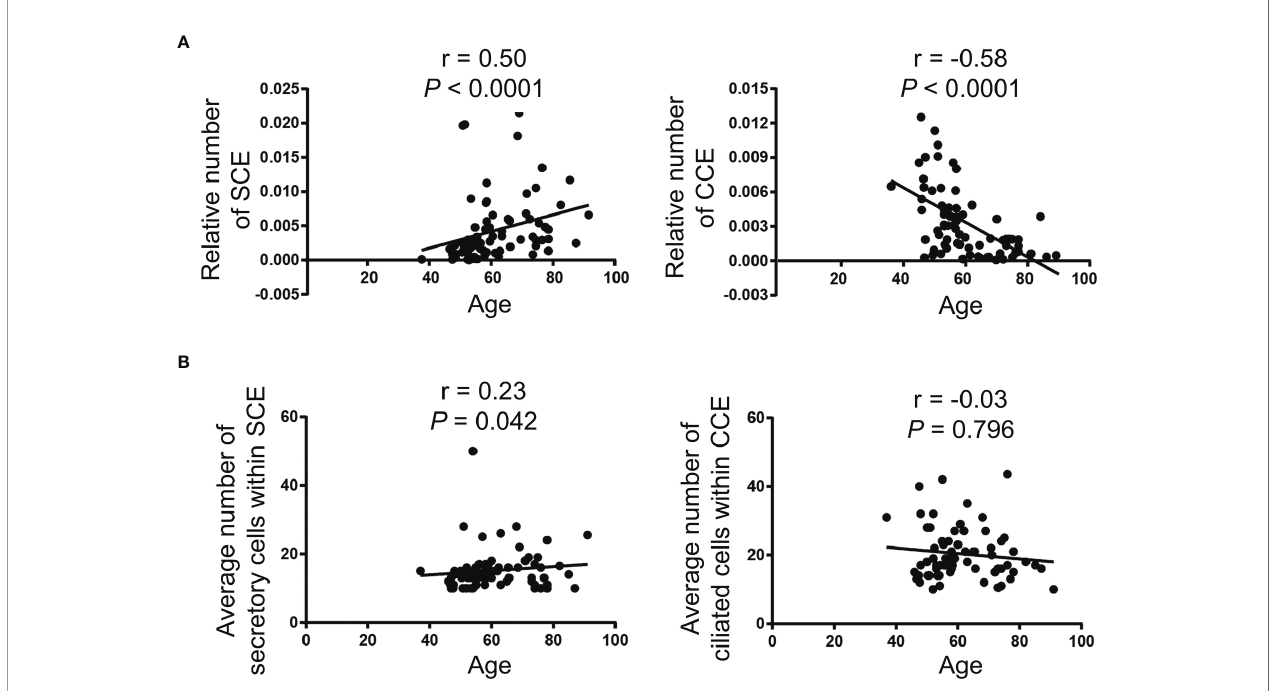
FIGURE 4 | Age is correlated with an increased relative number of SCE and a decreased relative number of CCE in the fallopian tube fi mbriae. (A) The relative number of SCE (left panel) and CCE (right panel) divided by the total number of epithelial cells in all ROIs on an individual slide. (B) The average number of secretory cells within SCE (left panel) and ciliated cells within CCE (right panel). The Spearman correlation (r) was used for the correlation